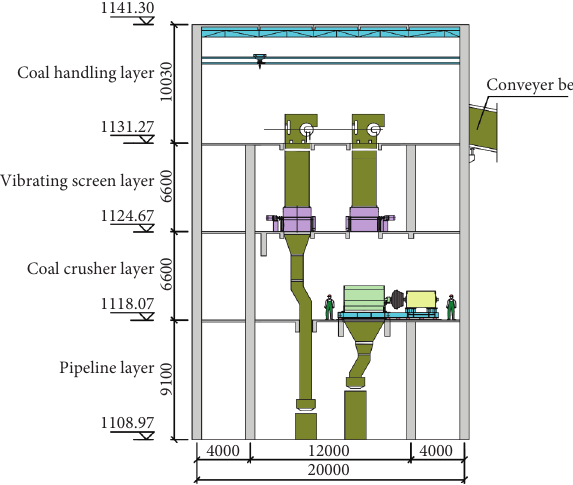
Figure 1: Coal crusher